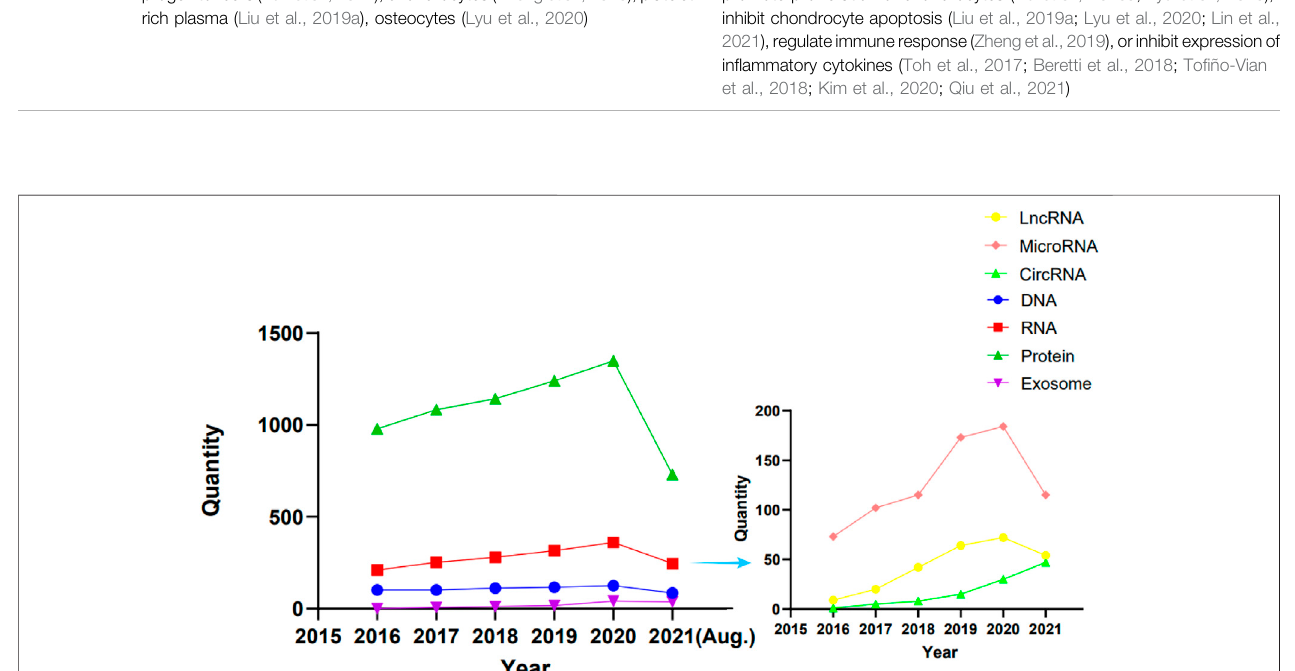
FIGURE 2 | Publication trends in biologics from January 2015 to August